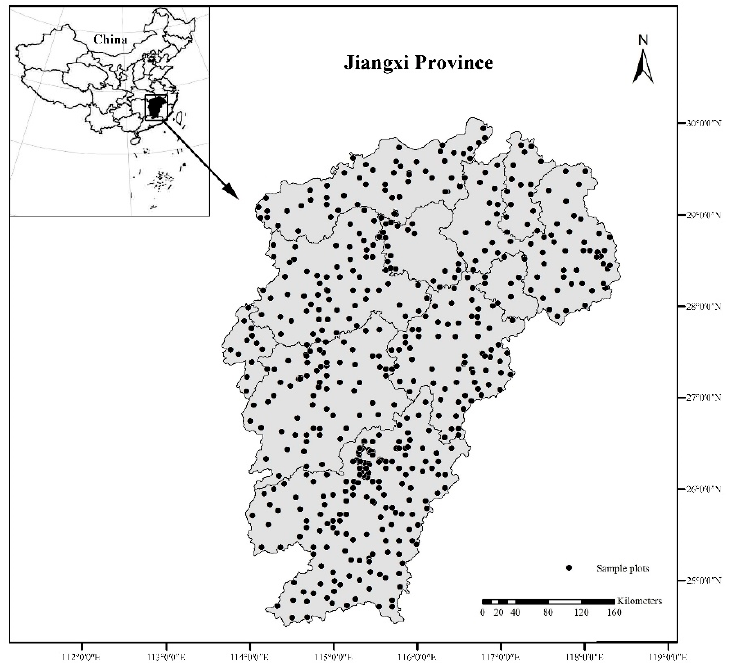
Table 1. Description of Pinus massoniana sample plots.